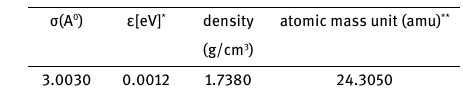
Table 1: Potential parameters, density and atomic mass unit of